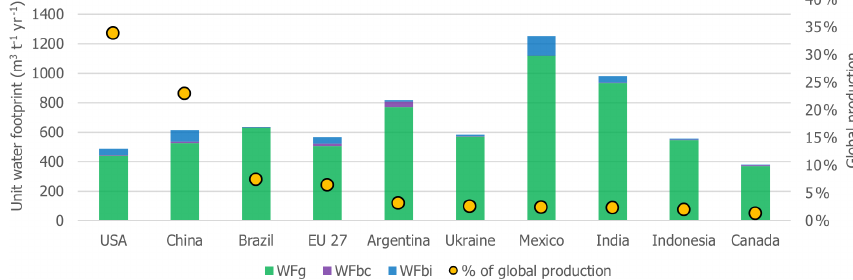
Figure 5. Average unit water footprint of maize (g – green, bc – blue from capillary rise, bi – blue from irrigation) in cubic metres per tonne